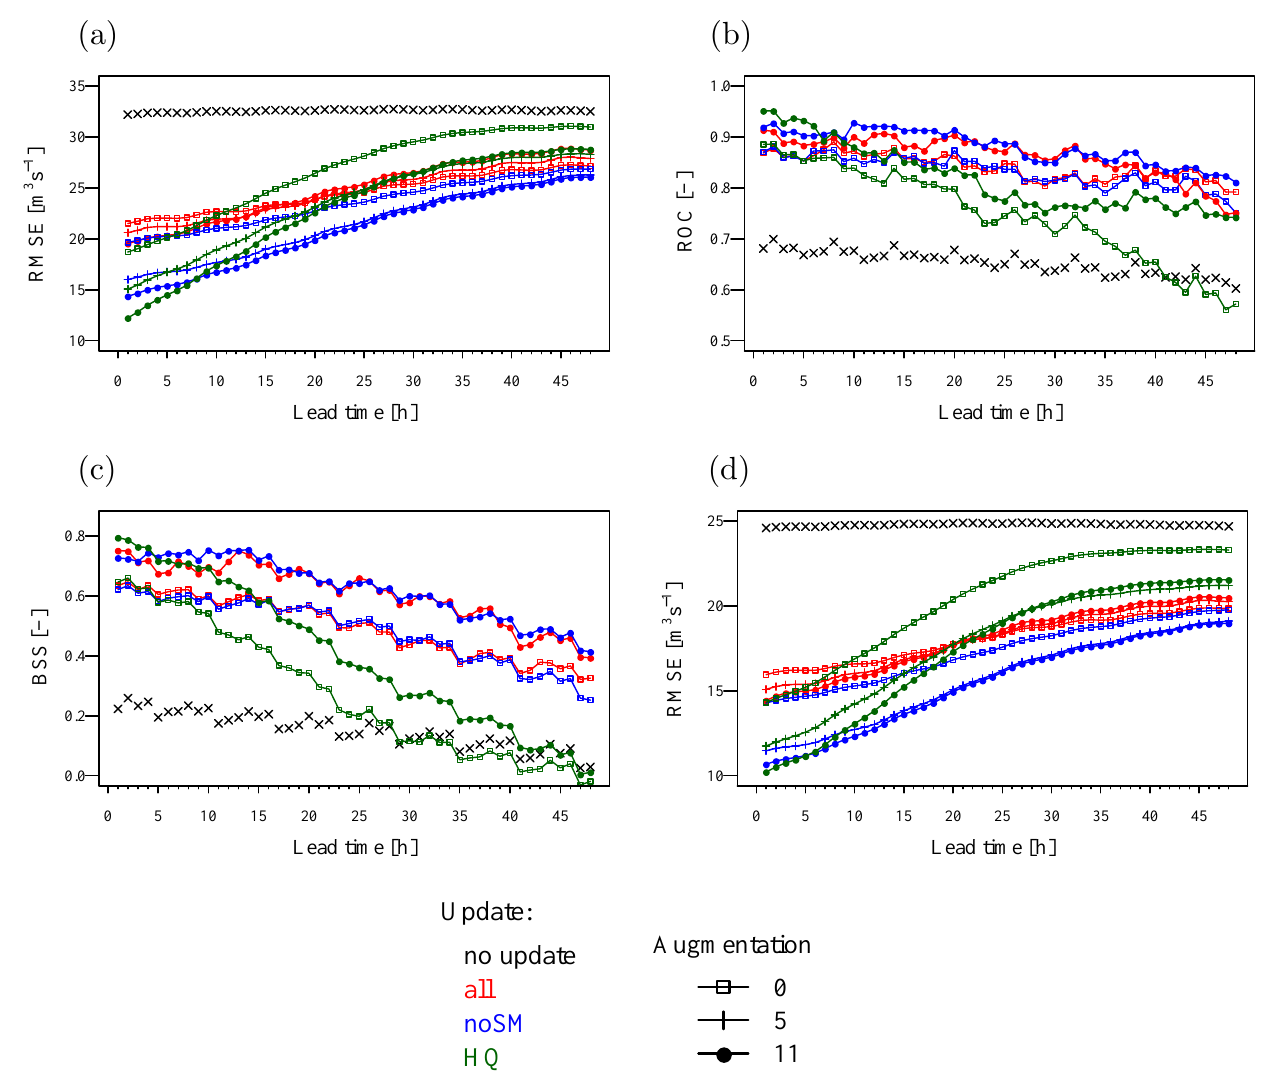
Figure 7. (a) Root-mean-square error (RMSE), (b) relative operating characteristic (ROC), and (c) Brier skill score (BSS) at Tabreux (gauge 1) for different discharge observation vectors for which different model states are updated and with different lengths of the state augmentation vector ( W ) of past observations being assimilated. The results incorporate a set of eight flood events shown in Table 1. Gauges 1, 3, 5, and 6 are assimilated. For BSS, the reference forecast is the sample climatology and only values larger than the 25th percentile of the whole sample are considered. (d) Same as (a) but the results are presented for Durbuy (gauge 2), a validation location which is not